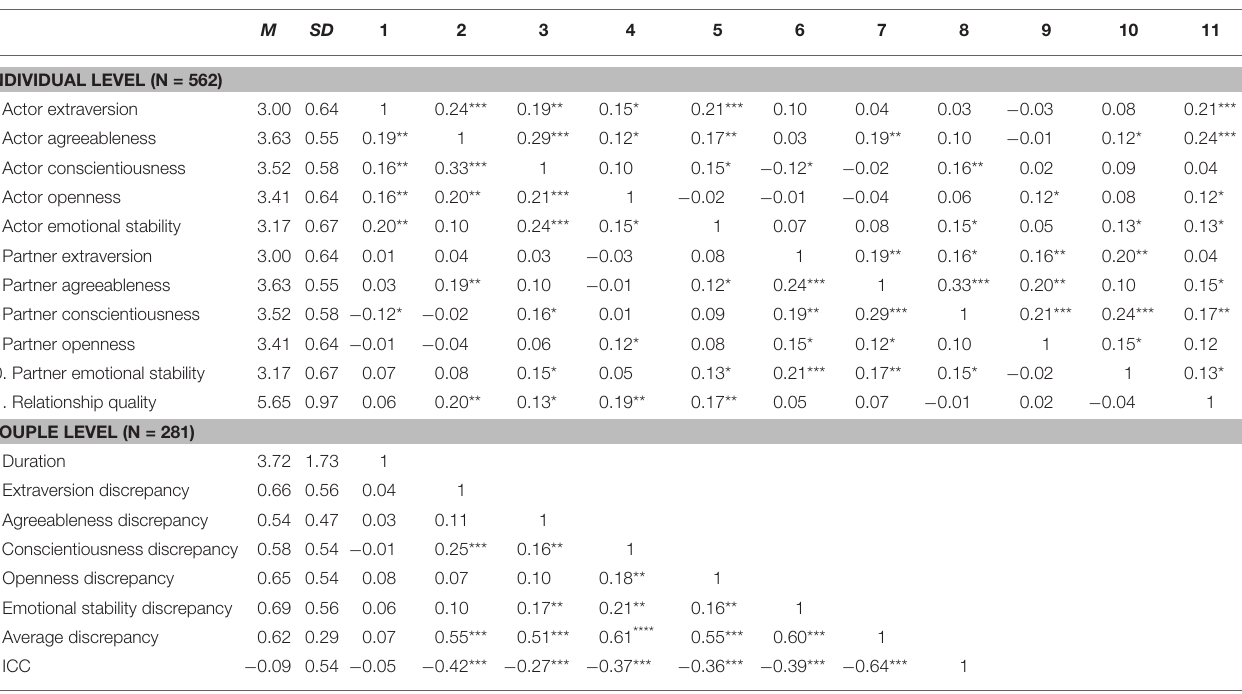
TABLE 1 | Correlations analysis among gender, duration, personality traits and profile similarity indices. M SD INDIVIDUAL LEVEL (N =